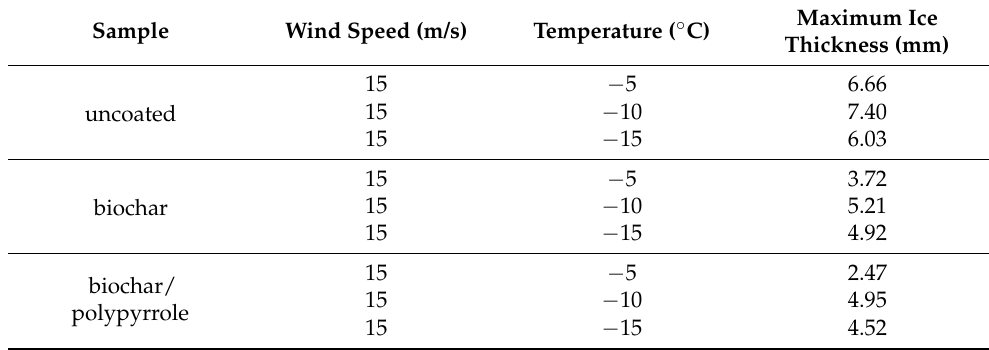
Figure 10. Comparison of the maximum icing thickness at the leading edge of the blade ( a ) at − 5 ◦ C; ( b ) at − 10 ◦ C, and ( c ) at − 15 ◦ C. Table 7. The maximum ice thickness of uncoated biochar and